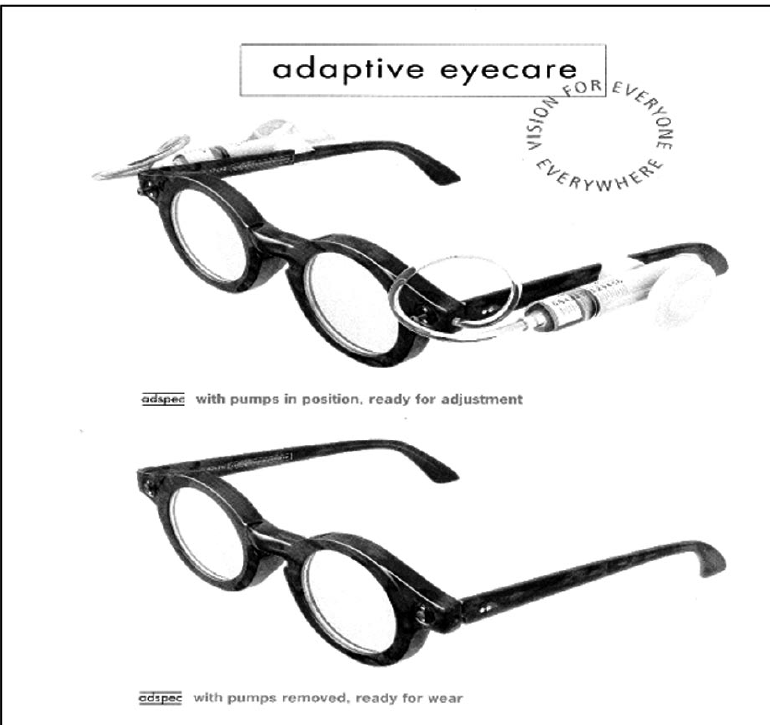
Figure 2. The Adspec TM . The top Figure shows the Adspec with the pumps on and ready for adjustment. The bottom Figure shows the Adspec with the pumps removed and ready for wear. (Reproduced with permission from Adaptive Eyecare